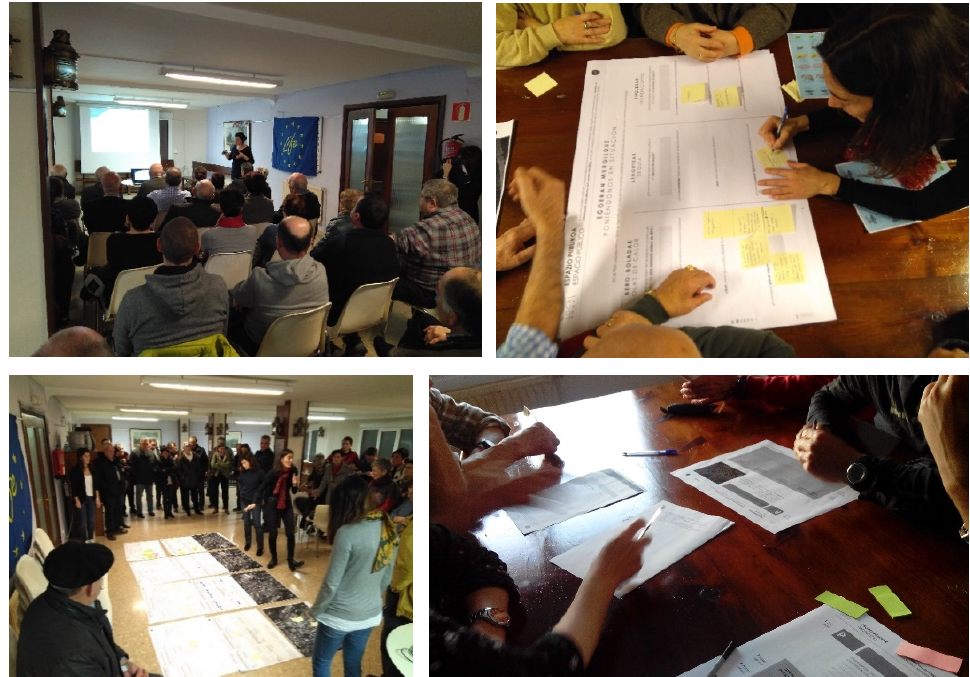
Figure 5. Images of the different sessions of the participation process (developed by the authors).